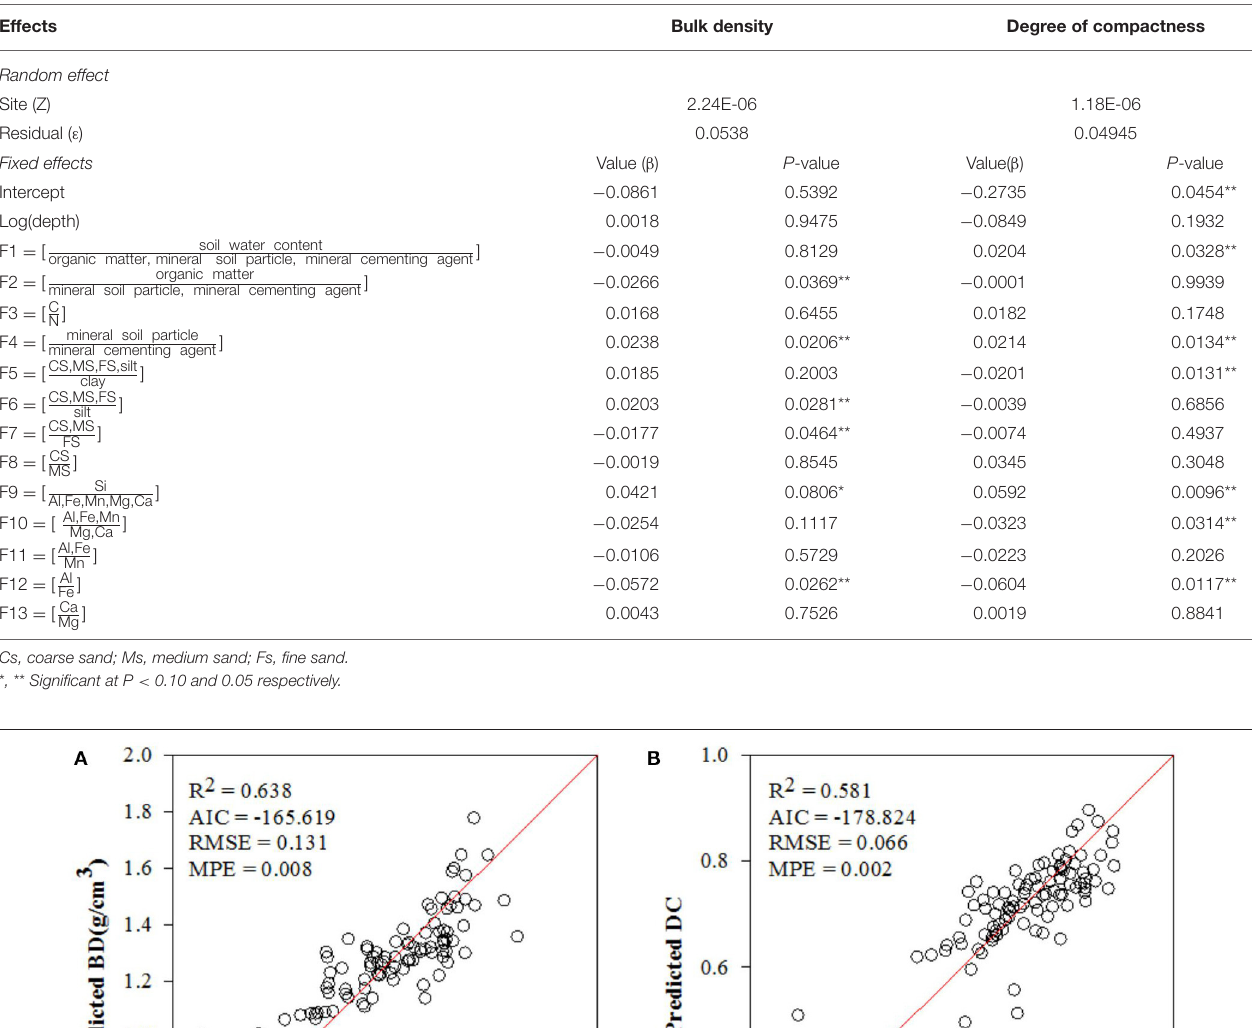
TABLE 4 | Linear mixed effects models for soil bulk density and degree of